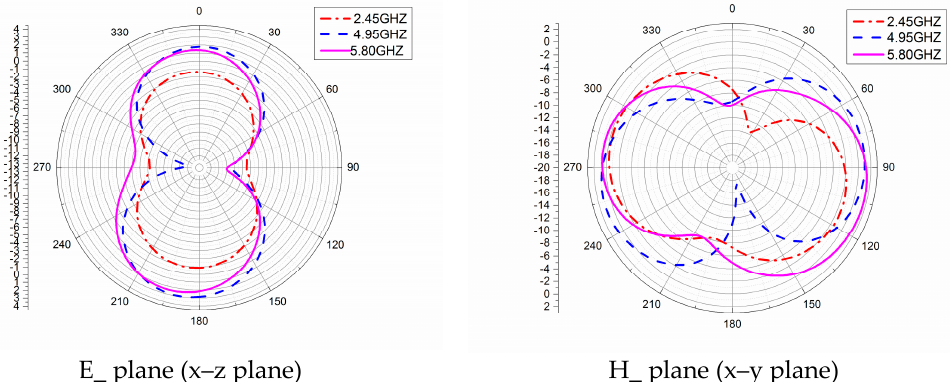
Figure 18. Radiation patterns of the proposed microstrip UWB antenna.